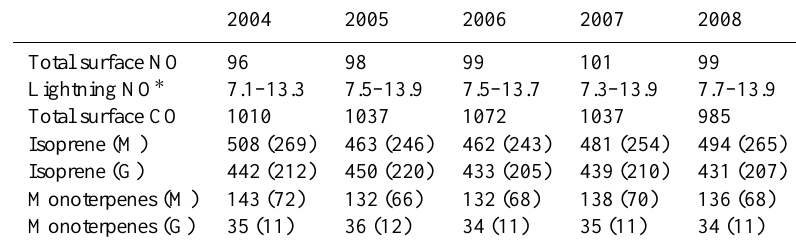
Table 1. Global annual total emissions (Tgyr − 1 ). Values in brackets are sums of SH emissions.